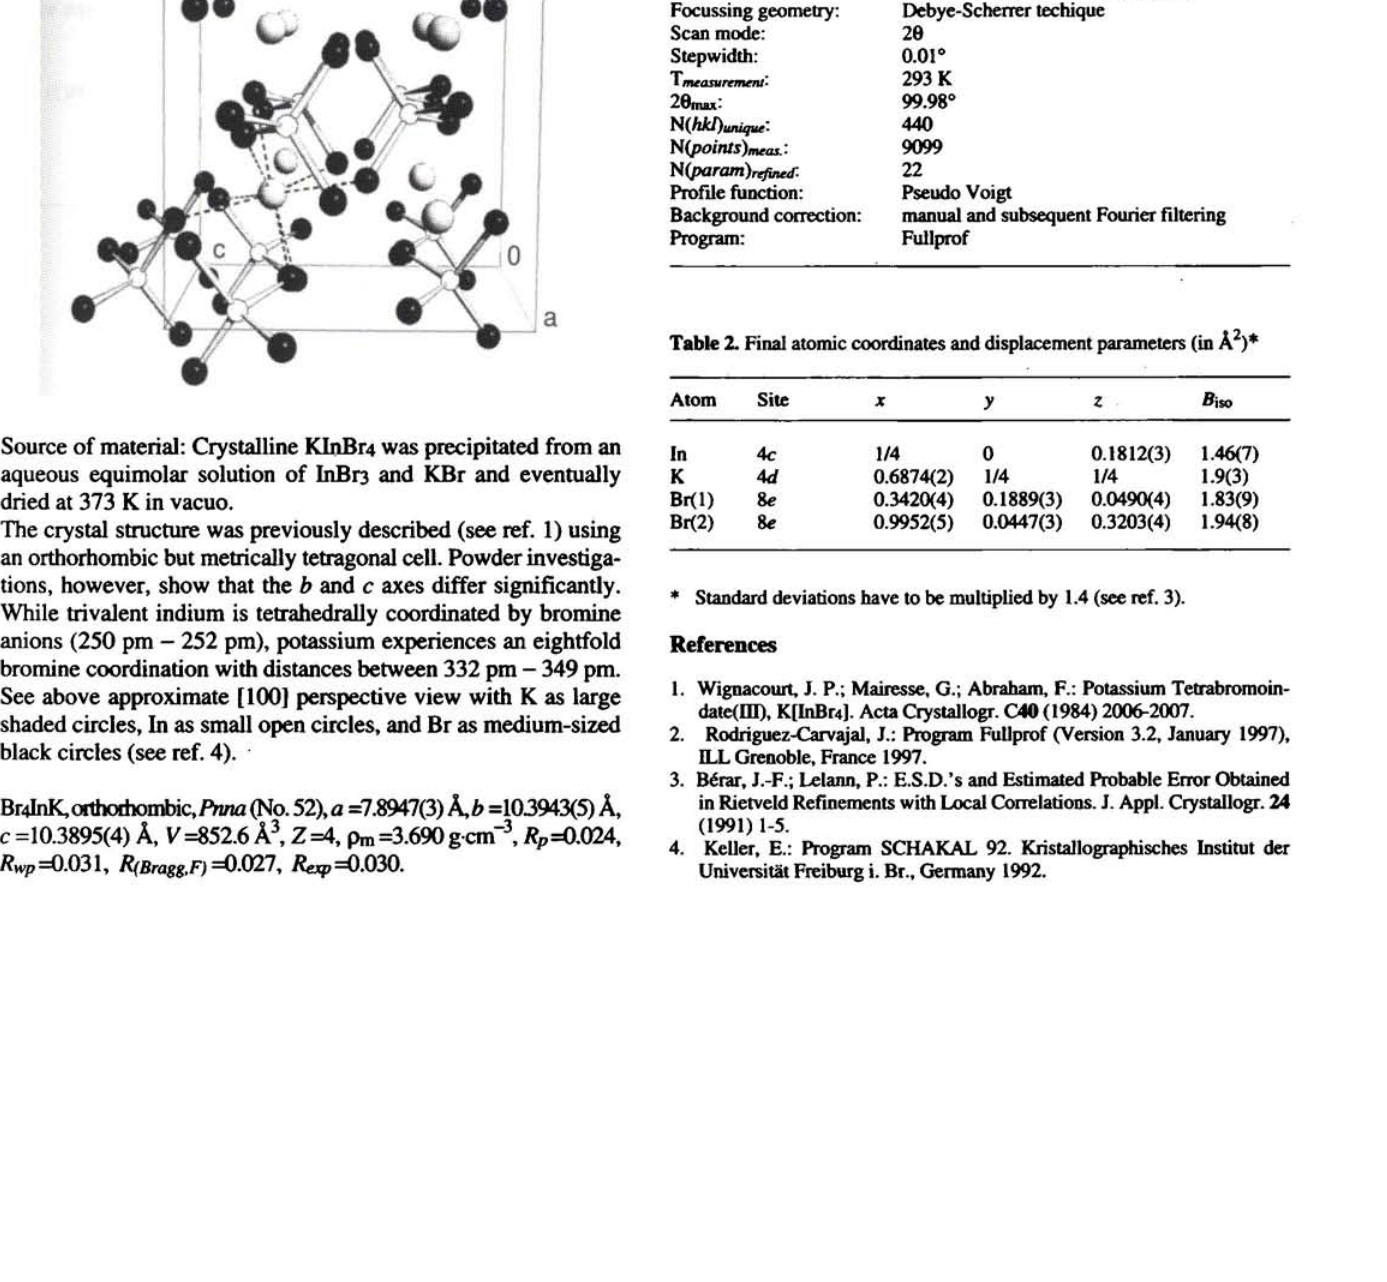
Focussing geometry: